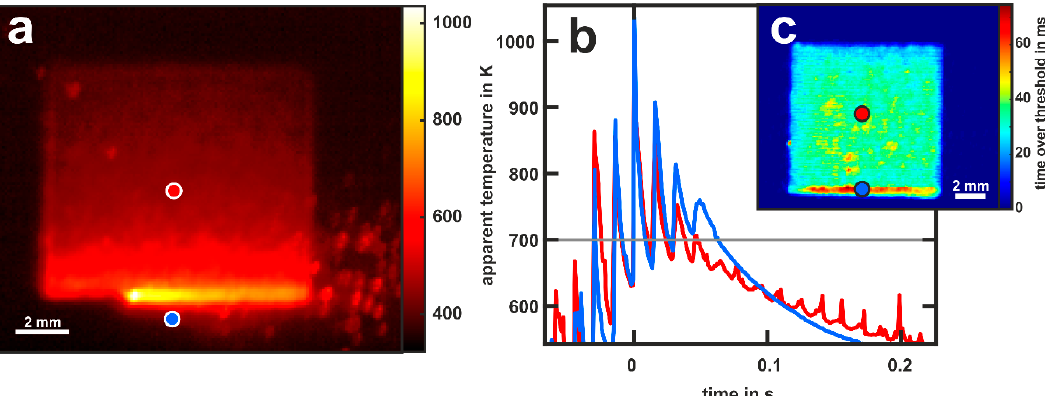
Figure 6. Thermographic data. ( a ) Thermogram of layer 45. In this layer, the exposition was performed in horizontal stripes from top to bottom in the image. In the shown frame, the laser moves from right to left; ( b ) time evolution of the apparent temperature in the positions (single pixels) marked in a. For better comparison, the time axes were shifted for each position to match the maximum apparent temperature at 0 s; ( c ) map of the time over threshold (TOT) for a threshold value of 700 K for layer 45 (see text).